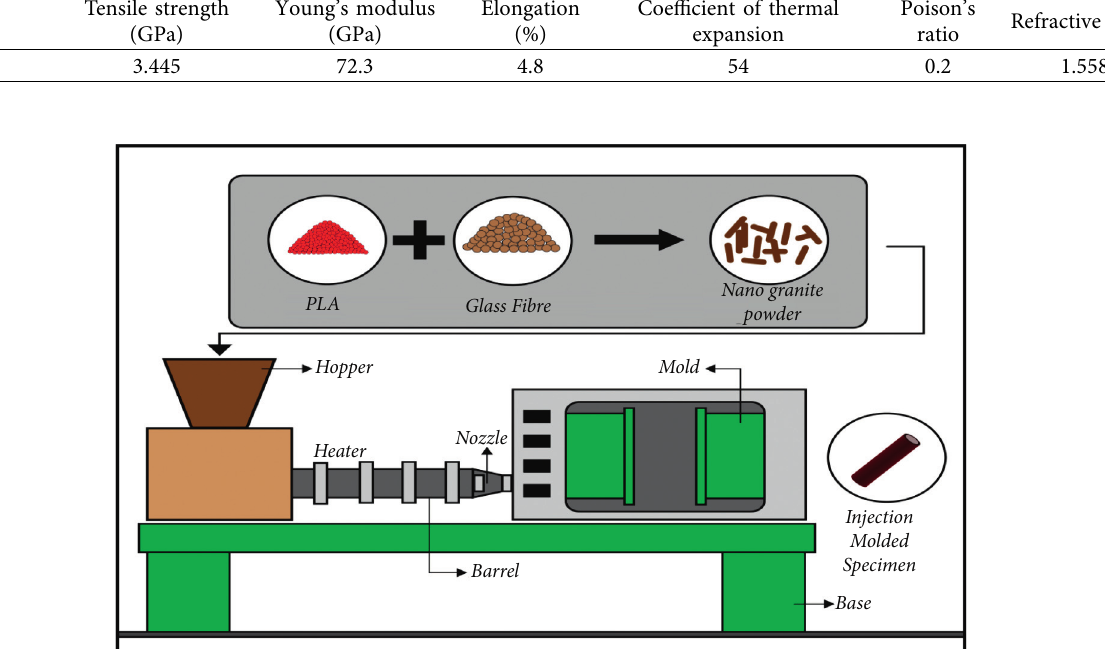
Figure 5: Twin screw extrusion process for making hybrid composite